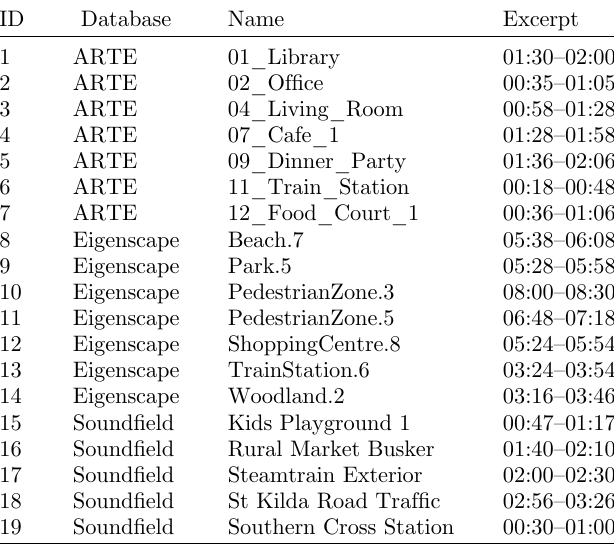
Table 6. Sample draw of soundscape excerpts for exemplary pairwise